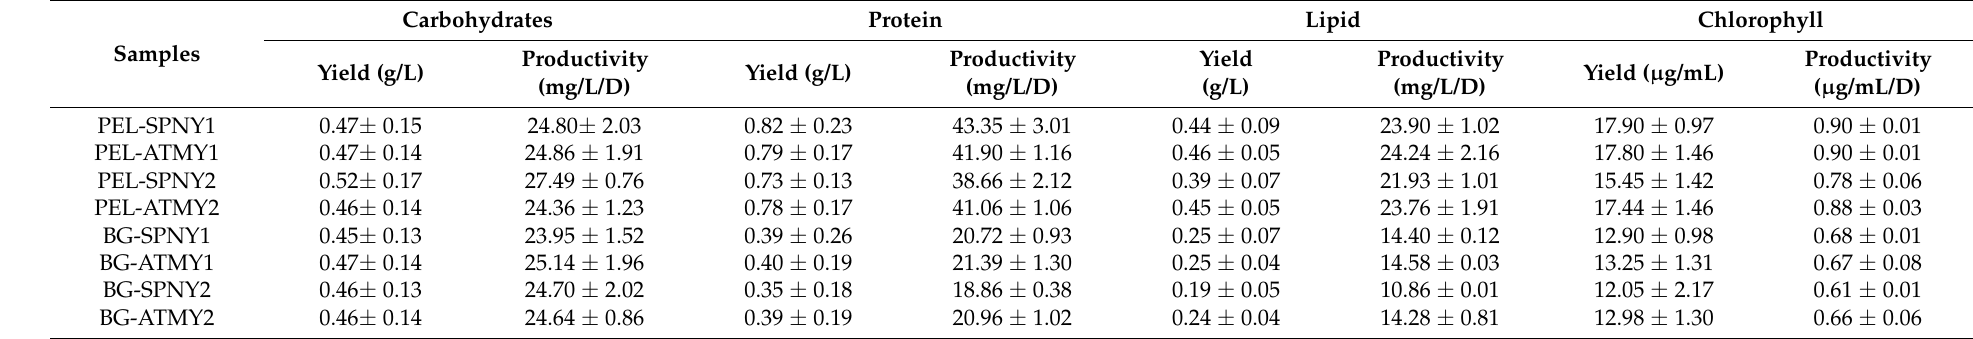
Table 2. Biomolecules yield and productivity of C. pyrenoidosa with PEL and BG-11 in